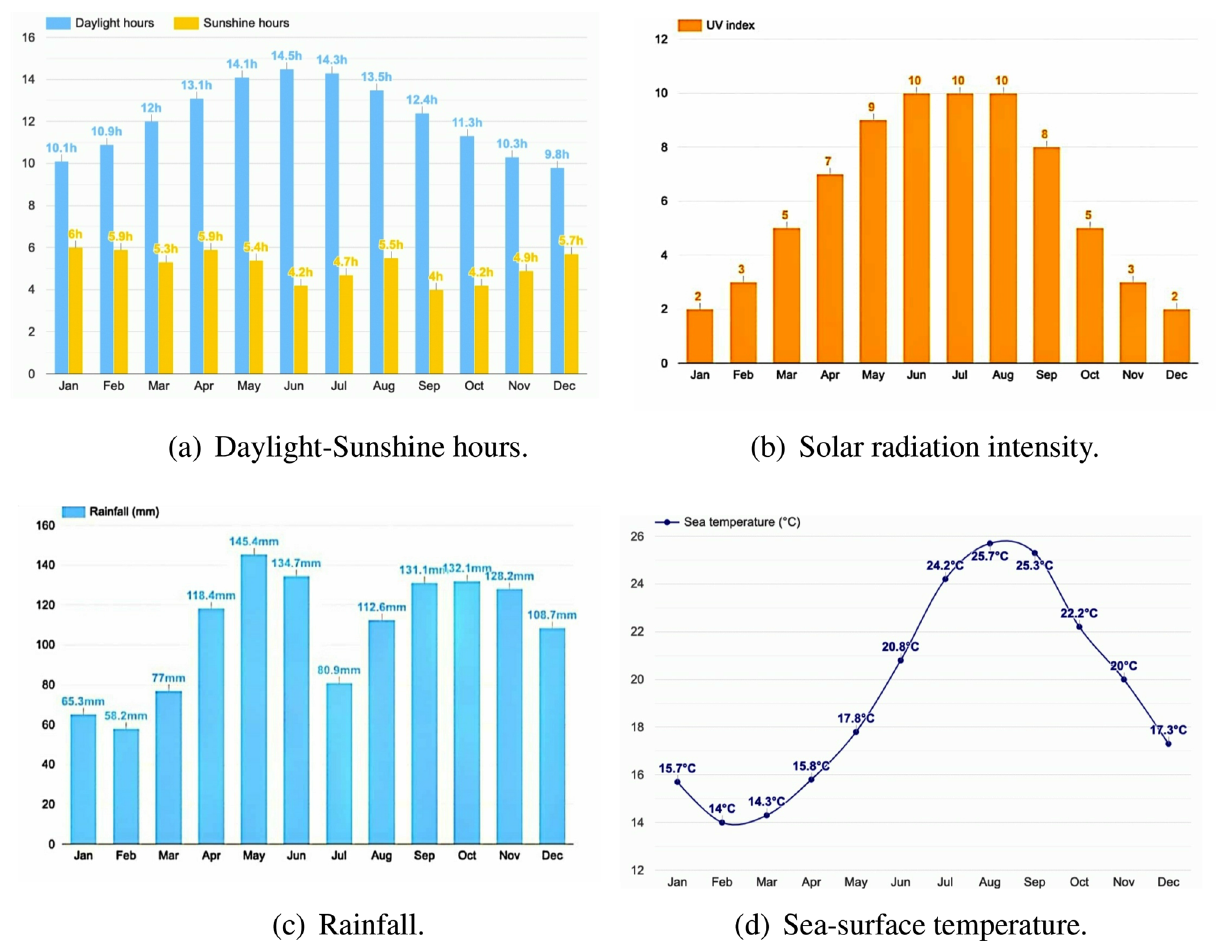
Figure 2. ( a ) Monthly daylight sunshine hours per day. ( b ) Average uv-index corresponding to every month inside and around Tokyo Bay, Japan. ( c ) Monthly average rainfall. ( d ) Sea-surface temperature inside and around Tokyo Bay (collected from 38